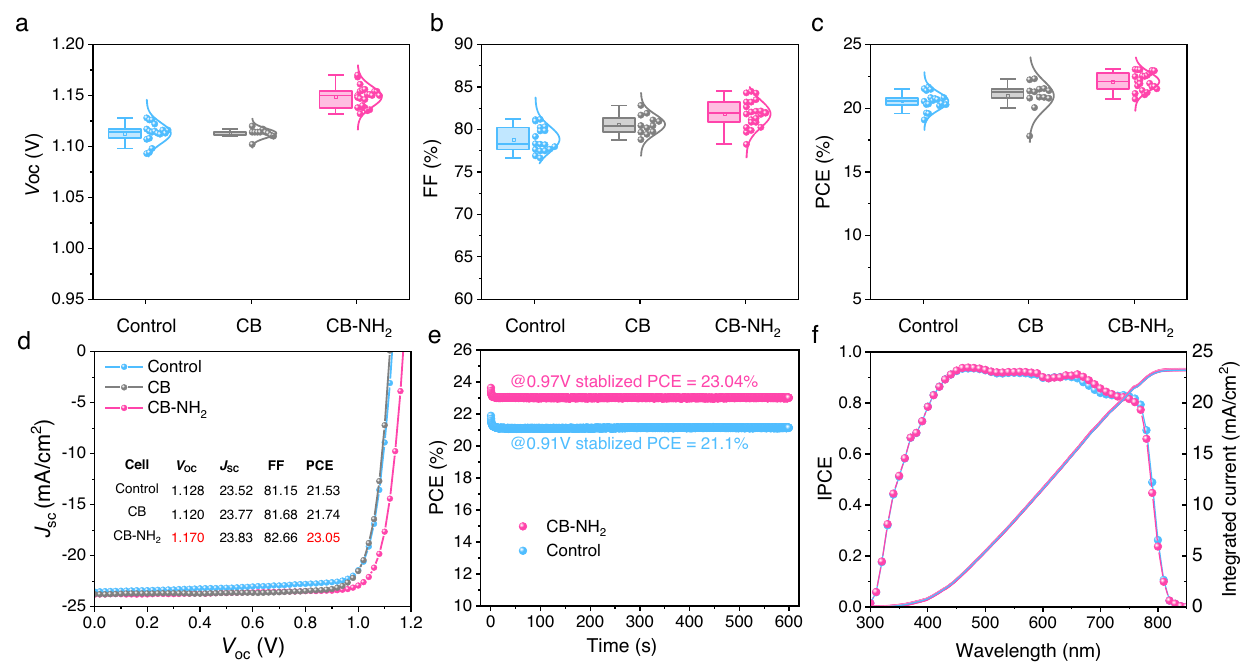
f Incident photon-to-current conversion ef fi ciency and the integrated current density results of CB-NH 2 treated and control cells. Source data are provided as a Source Data fi